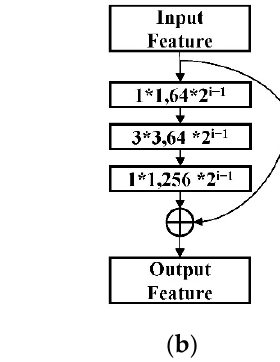
( b ) Figure 6. Structures of the attention modules. ( a ) Channel attention module. ( b ) Spatial attention module. The decoder module includes upsampling, summation, and convolutional layers (Figure 7). After concatenating the input feature map and the refined feature map ob- tained with the attention module, the result is forwarded to the upsampling layer with bilinear interpolation and 1 × 1 convolution, and then to the 3 × 3 convolutional layer. The input feature of the module is the output of previous stage, and the input of the first up- sampling module is only the refined feature. The above module is repeated to gradually recover the feature map to the original size and finally input the softmax layer for proba- bility prediction. The decoder integrates multi-layer shallow features to make up for the